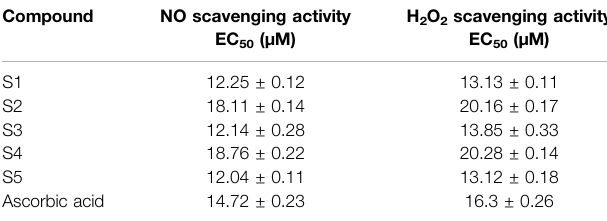
TABLE 1 | Antioxidant activity of sulfonamides derived from